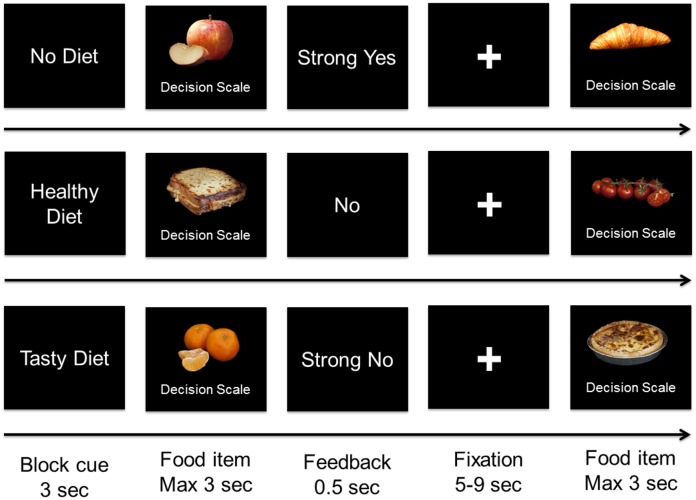
Task summary.Participants made decisions regarding whether or not to eat food items in three attentional conditions: (1) ND condition, (2) HD condition, and (3) TD condition.